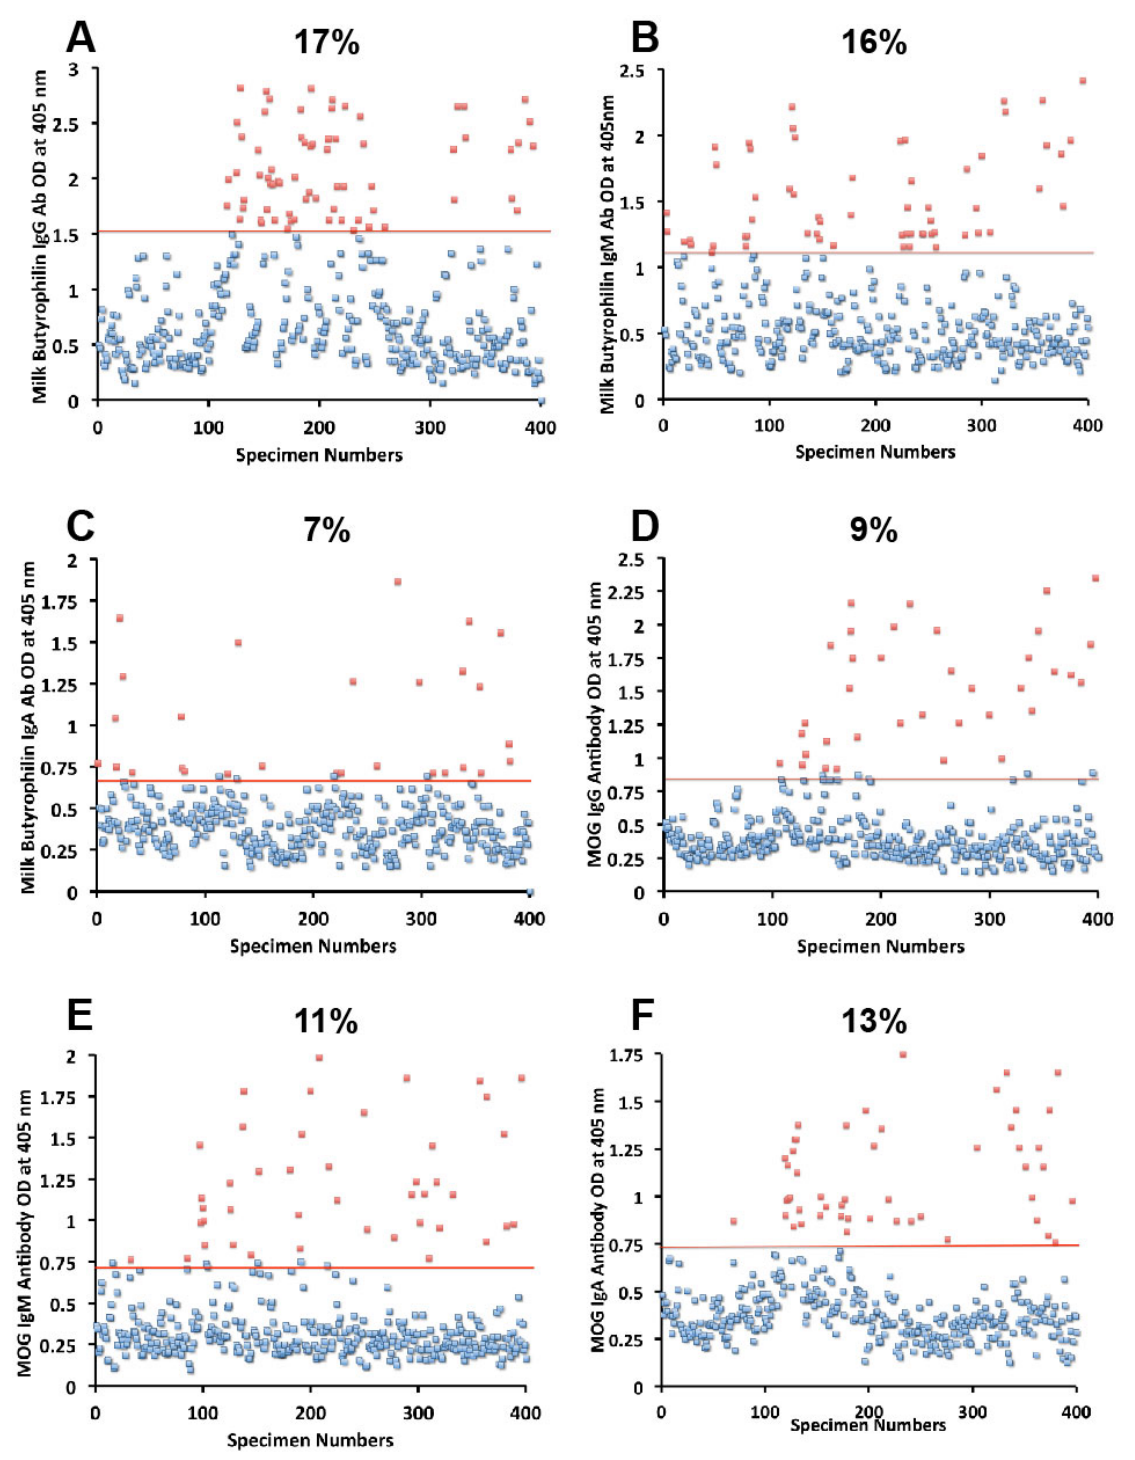
Figure 5. Results for milk butyrophilin and MOG expressed as OD at 405 nm in the form of scattergrams with percentages of elevation. ( A ) Milk butyrophilin IgG; ( B ) Milk butyrophilin IgM; ( C ) Milk butyrophilin IgA; ( D ) MOG IgG; ( E ) MOG IgM; ( F ) MOG